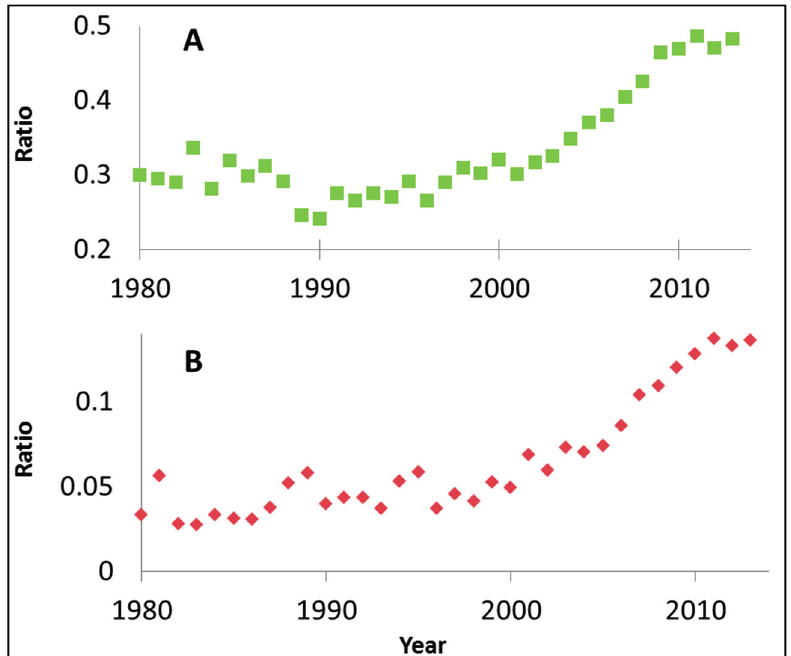
Figure 2. ( A ) The ratio between the number of manuscripts retrieved by SciFinder